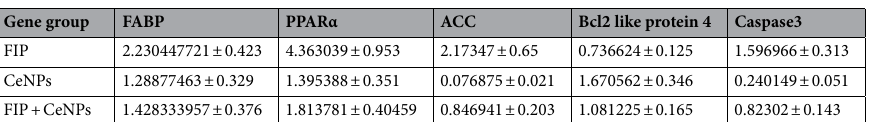
Table 5. mRNA expression of fatty acid-binding protein. The effect of cerium oxide nanoparticles (CeNPs) on liver mRNA expressions of FABP (fatty acid-binding protein), PPARα (peroxisome proliferator activated receptor- alpha), ACC (Acetyl COA Carboxylase), Bcl2 Like protein 4 and Caspase3 in FIP intoxicated rats. Data are expressed as Mean ± SE (n = 7). FIP Fipronil, CeNPs cerium oxide nanoparticles.